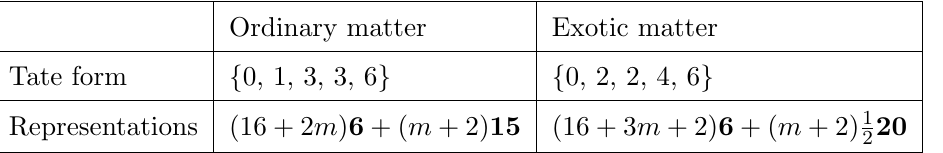
Table 18. Representations of su (6) and su (6) (cid:14) -tuning on curves of self-intersection m (cid:21) (cid:0)